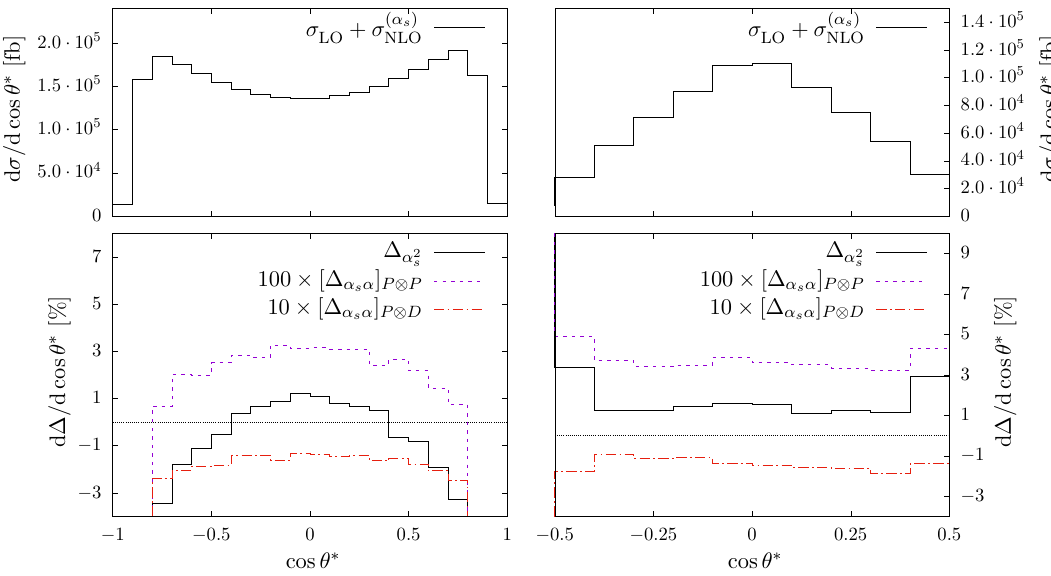
Figure 6. Relative di(cid:11)erential corrections (cid:1) for the cos (cid:18) (cid:3) distribution for 0 : 6 < j y ‘‘ j < 1 : 2 (left) and 1 : 8 < j y ‘‘ j < 2 : 4 (right). See text for further details.